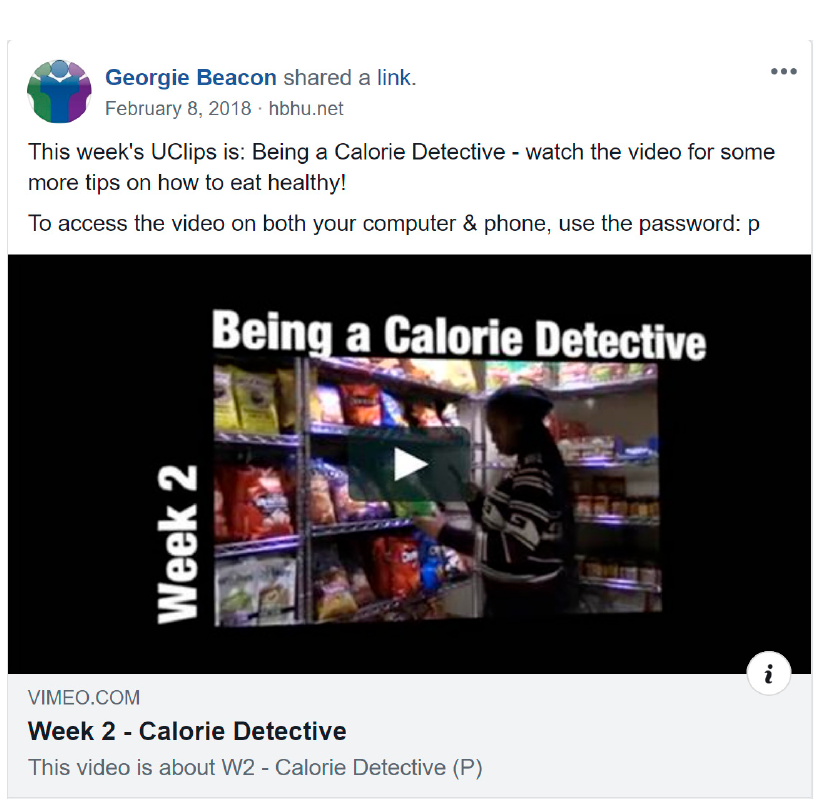
Figure 3. Sample weekly Didactic Vignette as posted by the study team (“Wk2_Th” in Table